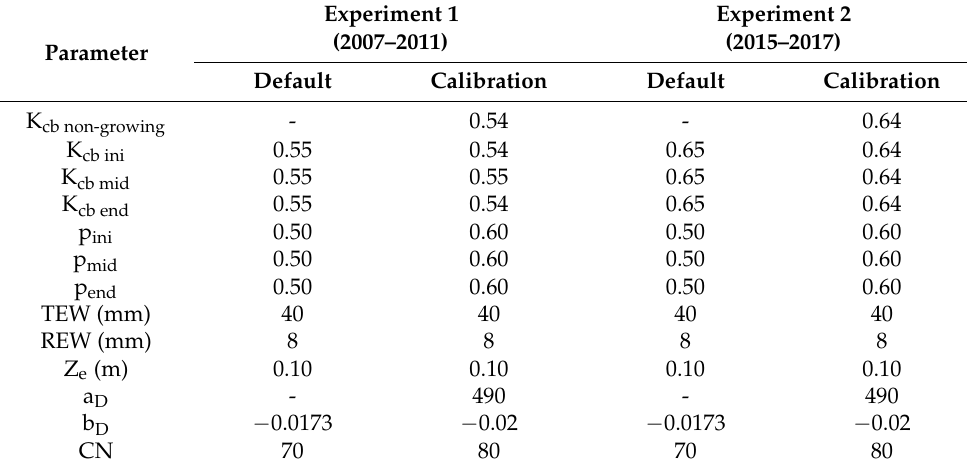
Table 7. Default and calibrated model